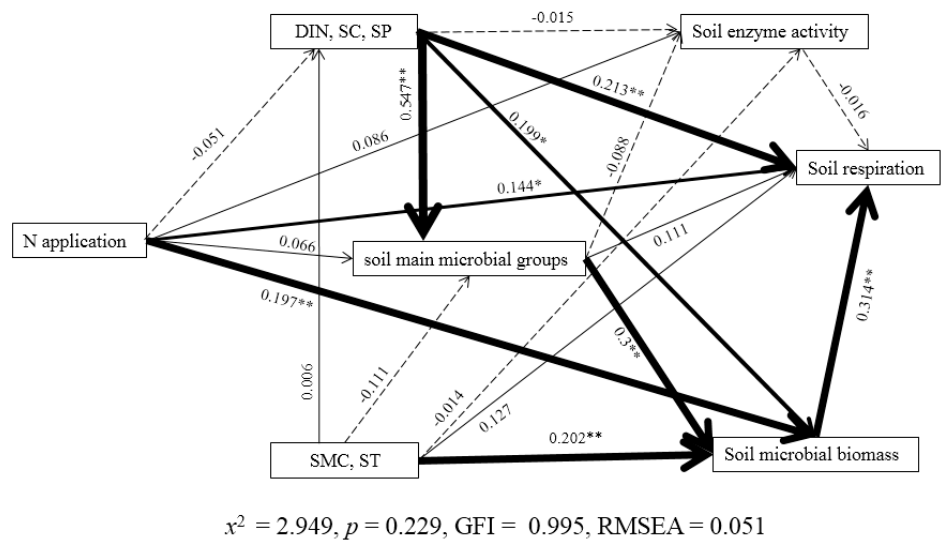
Figure 8. Structure equation modeling depicting direct and indirect regulatory pathways of environmental factors that affect soil respiration, microbial biomass, enzyme activity, and soil main microbial groups at N application in the subalpine coniferous forest. Arrows represent positive (solid) or negative (dashed) path coefficients. Arrow width is proportional to the strength of the relationship. Numbers on the arrows are standardized direct path coefficients. * p < 0.05; ** p < 0.01.